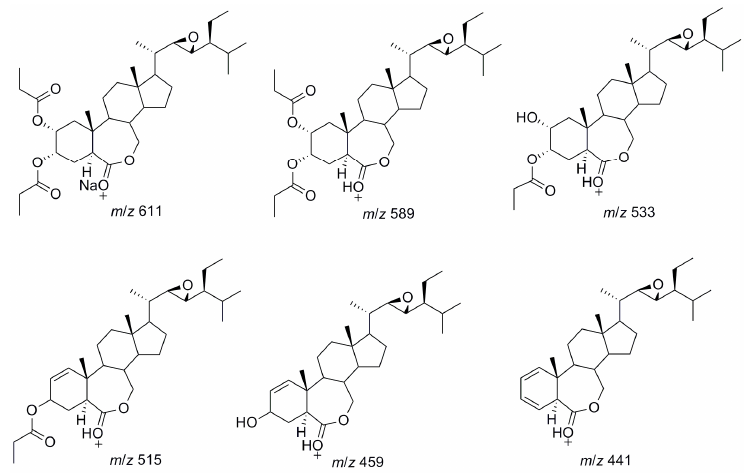
Figure 6. Proposed structure of the major mass ions for propionylbrassinolide.